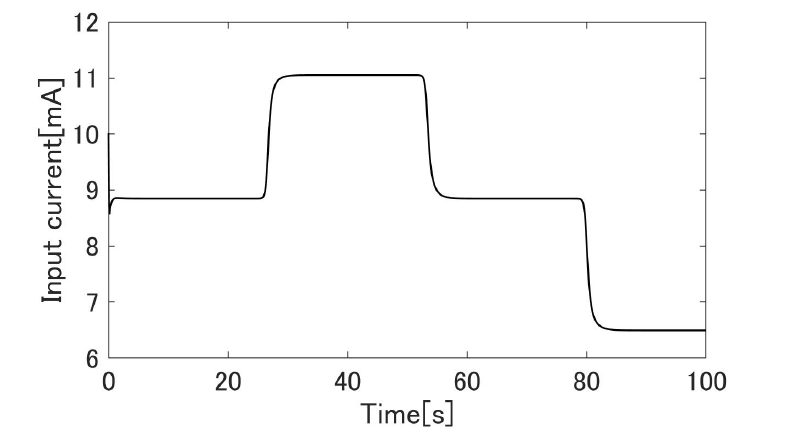
Figure 10. Input current u .